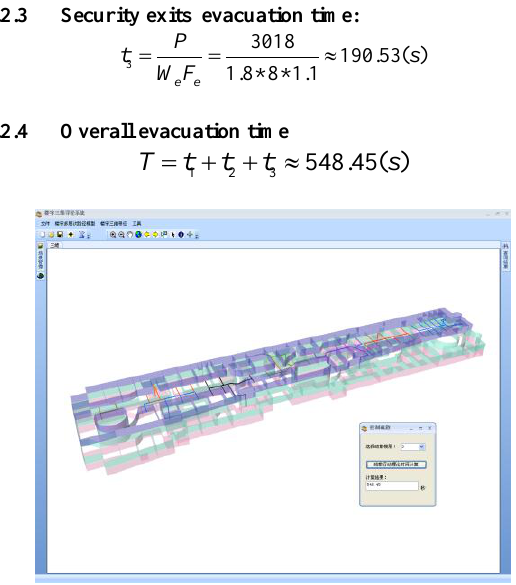
Figure 12 The result of evacuation route construction in Longjiang New City Plaza